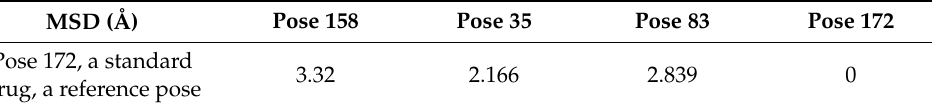
Figure 27. Ligand map showing the secondary interactions between pose 83, one small ligand, and enzyme 2VF5.